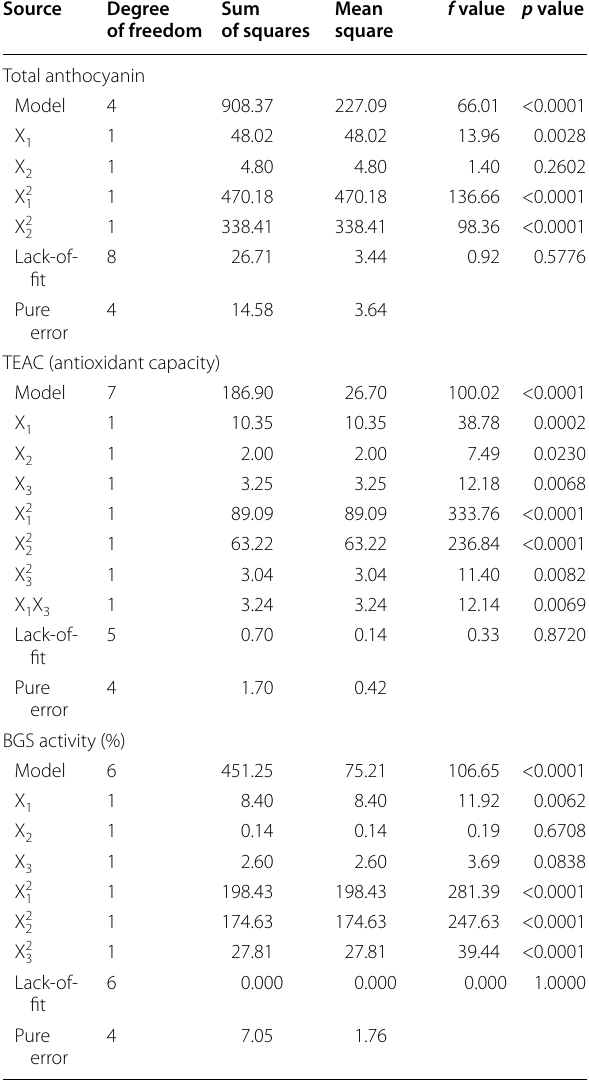
Table 3 Analysis of variance (ANOVA) for the quadratic model of ACN content, TEAC and BGS